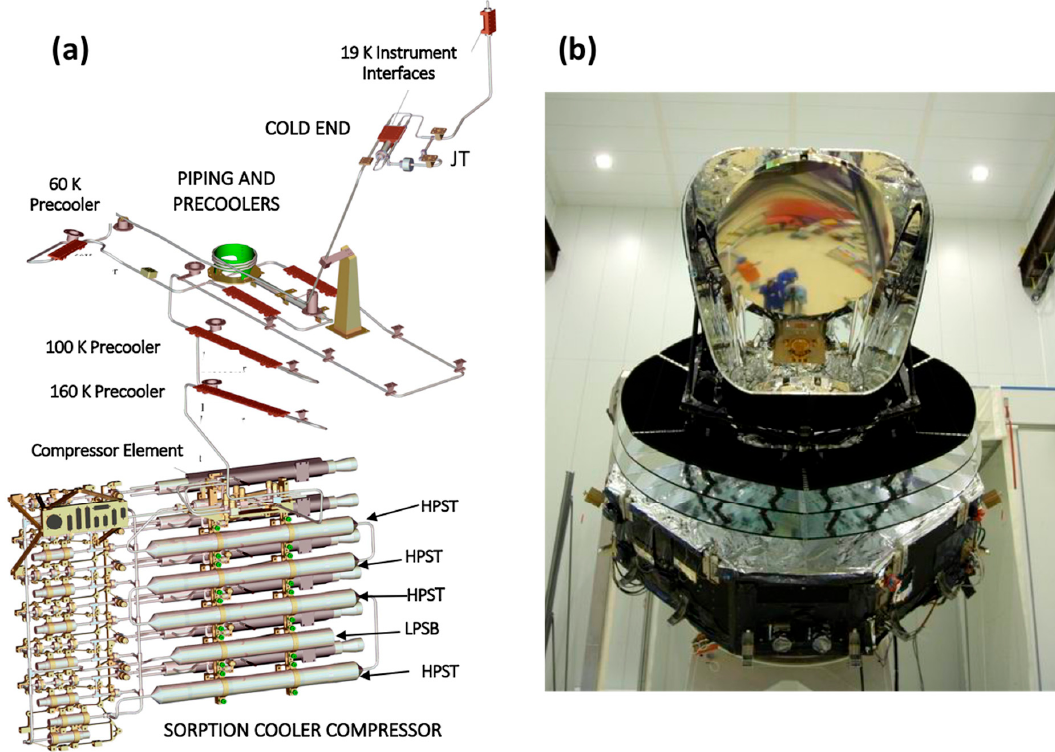
Figure 10. ( a ) Model view of the FM1 sorption cooler where LPSB denotes the Low-Pressure Storage Bed and HPST points to one of the four High-Pressure Storage Tanks that moderated pressure fluctuations during J–T compression: FM2 sorption compressor was identical except the piping and precoolers assembly was a mirror image. The precoolers are attached to the spacecraft V-grooves. The sorption compressor is attached to the warm radiator panel [36]. ( b ) A photograph of the fully assembled Planck satellite in 2009 just a few days before integration into the Ariane 5 rocket [9].